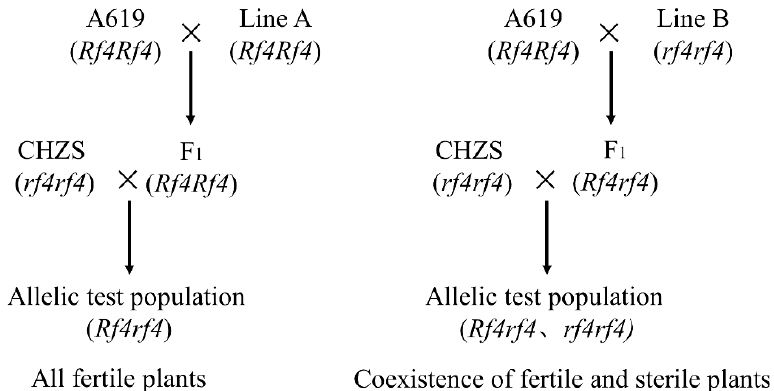
Figure 1. Flowchart of allelic tests of the CMS-C restorer gene Rf4